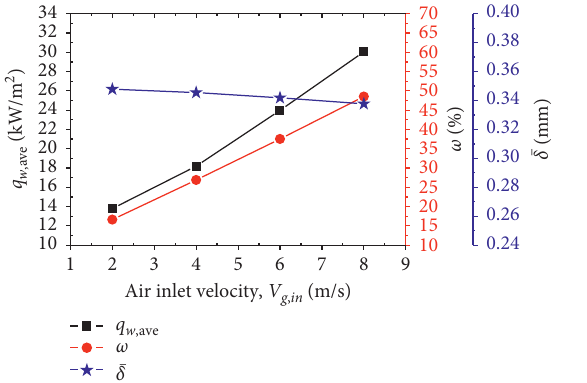
Figure 12: Influence of the air inlet relative humidity on heat and mass transfer of the water film evaporation